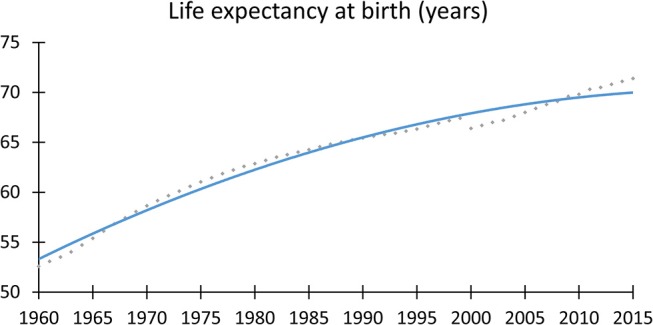
Life expectancy at birth. There is a steadily rising average life expectancy at birth. It has dramatically risen by 16 years (from 55.4 to 71.4 y) in the last half century. Data sources: between 1960 and 1999, World Bank; between 2000–2015, WHO.